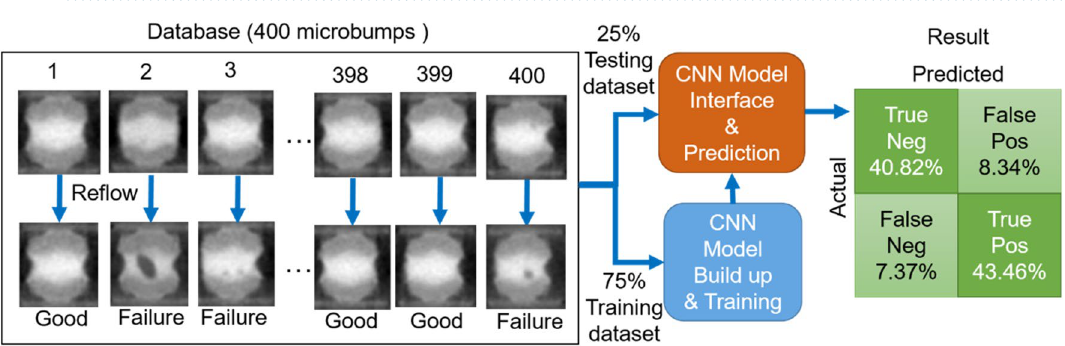
Figure 2. SEM images and CT images in the XY, XZ, and YZ planes of a selected microbump at ( A ) the initial state, the state of the resistance increased by ( B ) 10% and ( C ) 20%.